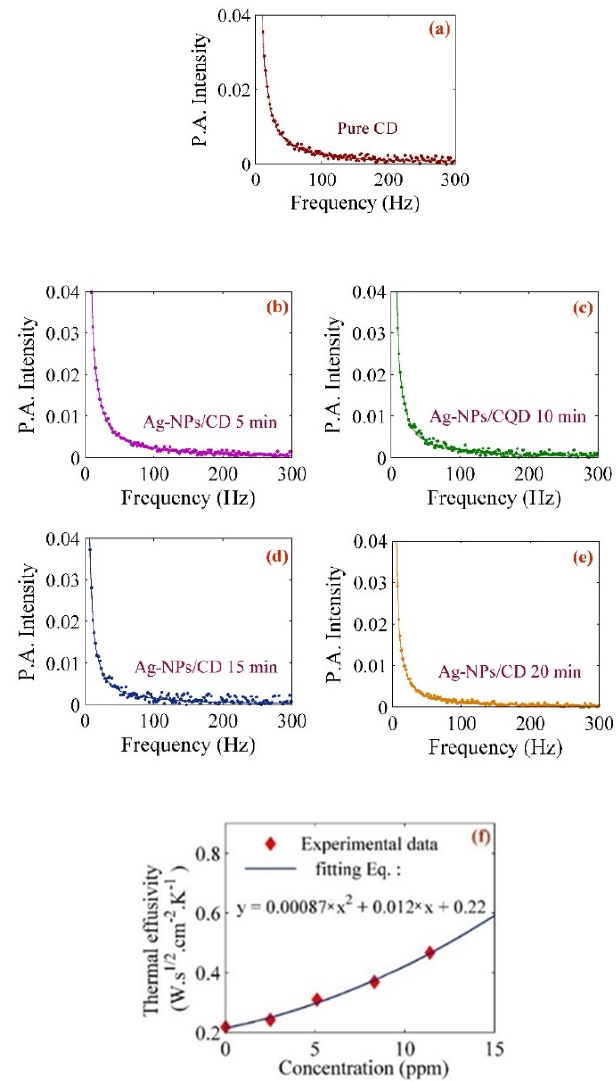
Figure 7. Photoacoustic signals used to determine the thermal effusivity of the ( a ) pure CD, Ag–NPs/CD ( b ) 5 min, ( c ) 10 min, ( d ) 15 min, and ( e ) 20 min ablation times. ( f ) Variation of thermal effusivity for Ag–NPs/CD with concentration.